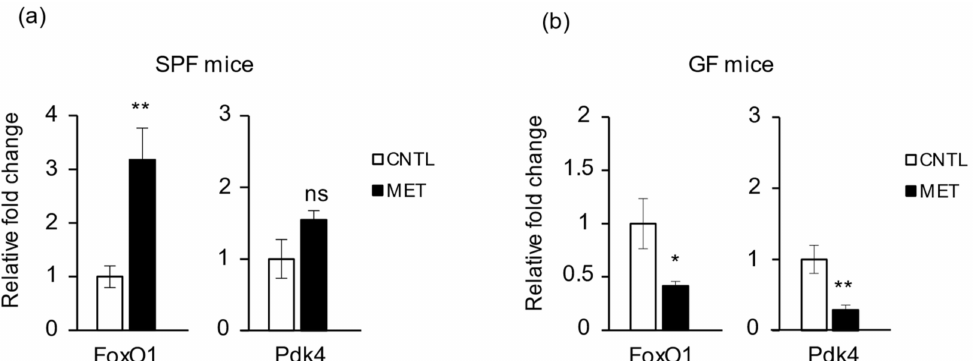
Figure 4. Metronidazole affects the expression of skeletal muscle metabolism genes. Real-time quantitative PCR analysis of FoxO1 and Pdk4 expression in gastrocnemius of metronidazole-treated and nontreated ( a ) SPF and ( b ) GF mice. N = 5 mice per group. Data presented as means ± SEM. Asterisks indicate statistically significant differences (*, p < 0.05; **, p < 0.01; ns, nonsignificant with student’s t